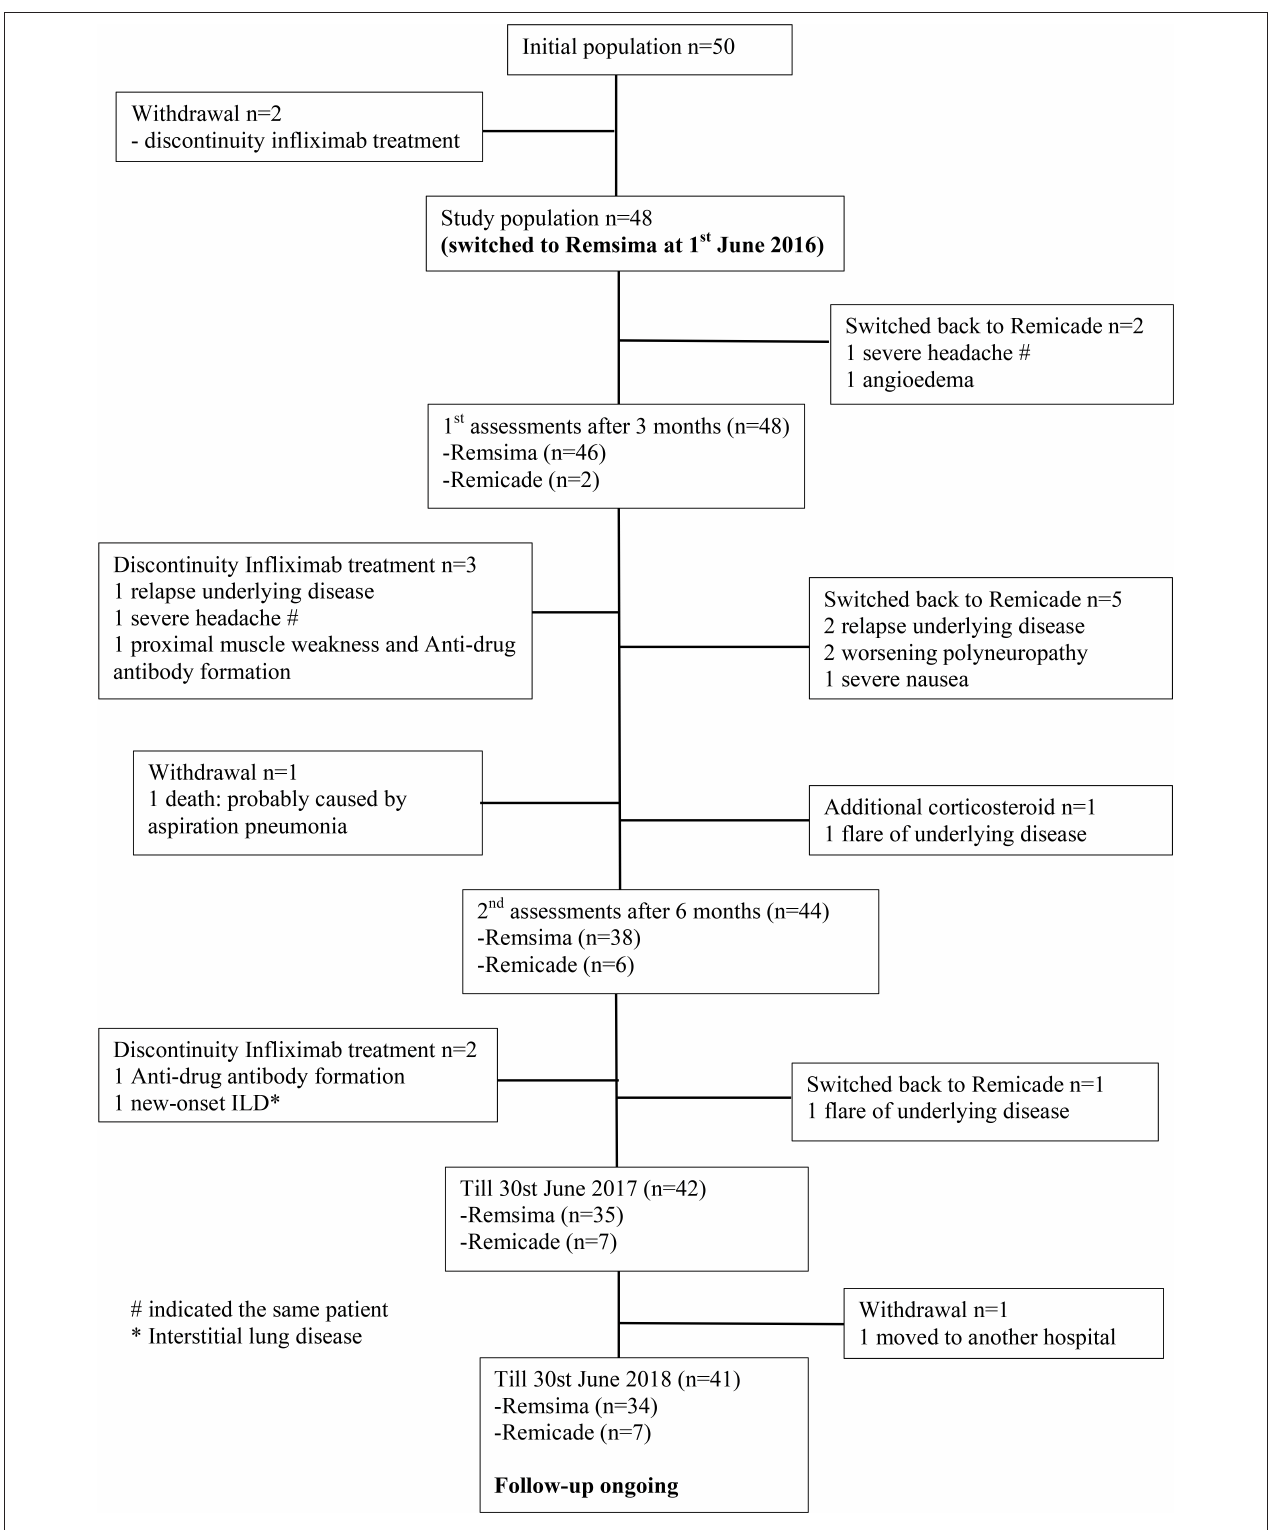
FIGURE 1 | Flowchart study